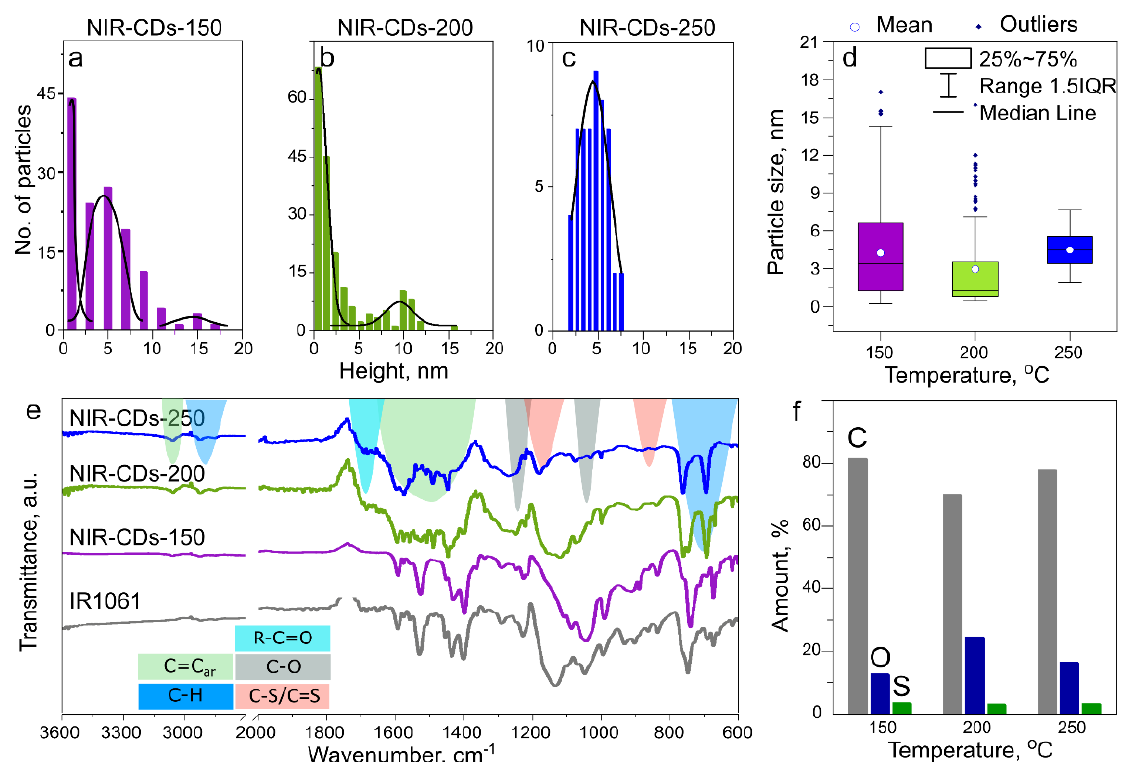
Figure 4. Morphology of NIR-CDs dependent on the temperature of synthesis: height distribution obtained from the analysis of AFM images for NIR-CDs-150 ( a ), NIR-CDs-200 ( b ), and NIR-CDs-250 ( c ); ( d ) statistics of the NIR-CDs heights depending on annealing temperature (IQR—interquartile range); ( e ) FTIR spectra; ( f ) chemical composition determined from XPS measurements.